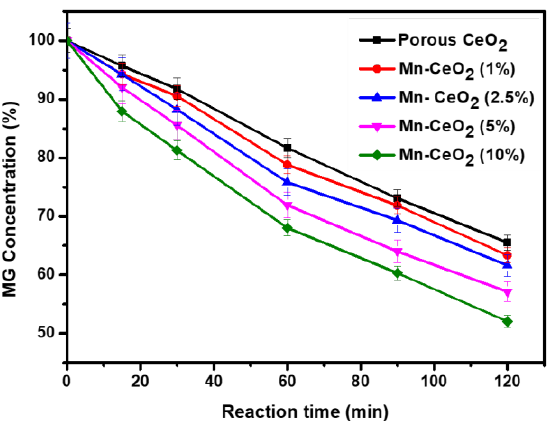
Figure 7. The decolorization profiles of MG dye over the prepared porous cerium oxide with and without Mn doping.